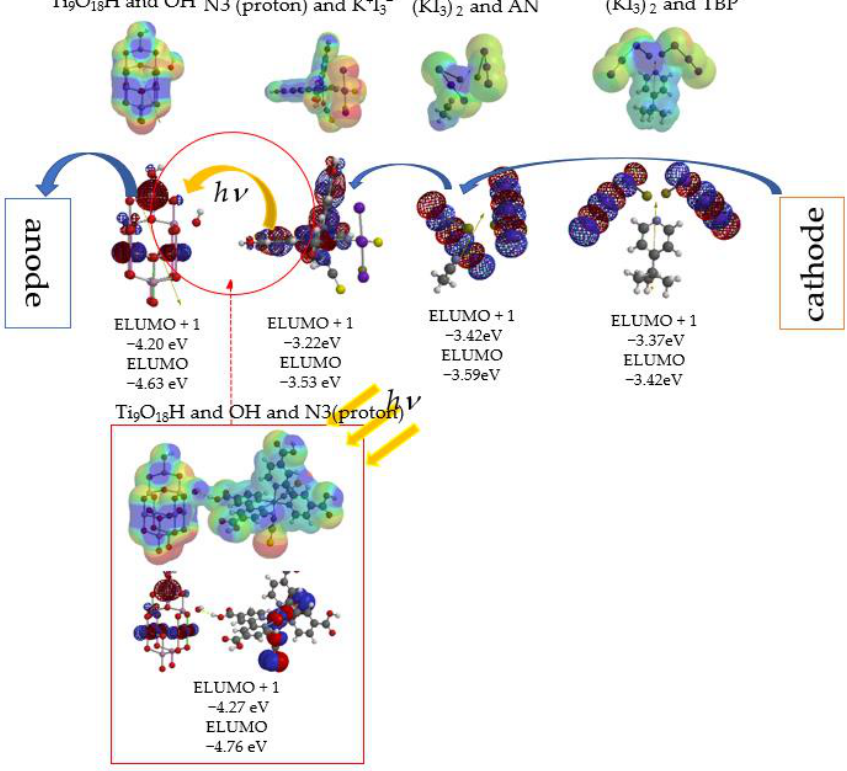
Figure 11. Visualization of unidirectional electron diffusion via vdW aggregation in DSSC composed of Ti 9 O 18 H and OH/N3 (proton) /KI 3 in acetonitrile (AN).